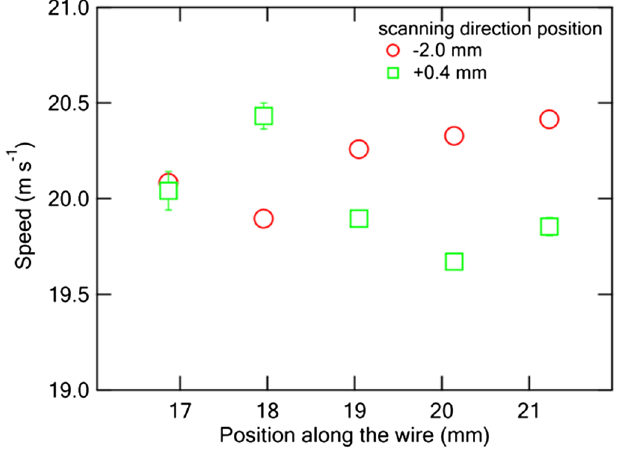
FIG. 8 (color online). Wire speeds calculated at different locations along the wire and at two different scanning positions. The circles represent values calculated using the average between peaks (1) and (2), while the squares use peaks (2) and (3). The error bars are smaller than the symbol size for some of the points.